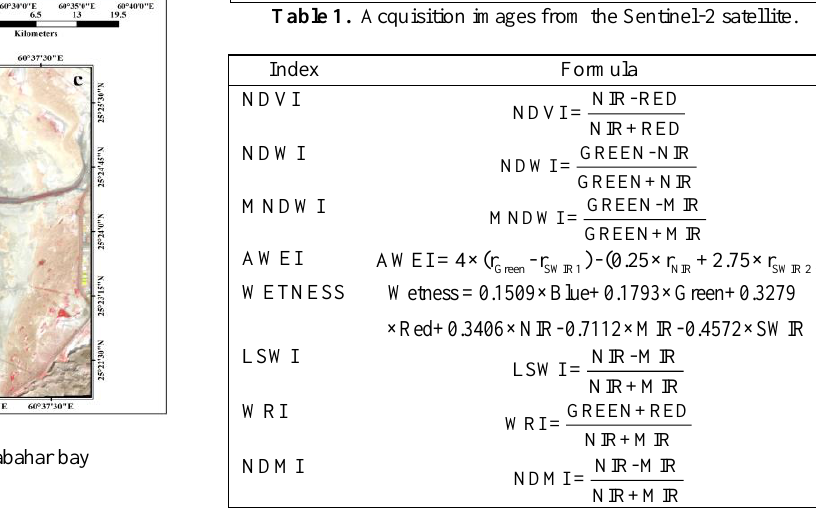
Table 2. Water extraction